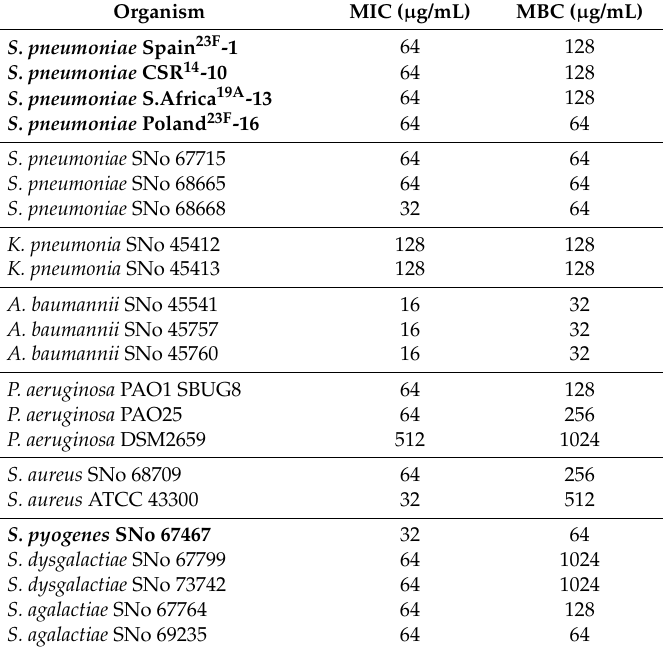
Table 1. Minimal inhibitory concentration (MIC) and minimal bactericidal concentration (MBC) in µ g/mL for allicin. The MICs and MBCs were determined following EUCAST (European Committee on Antimicrobial Susceptibility Testing) guidelines. MDR strains are shown in bold.